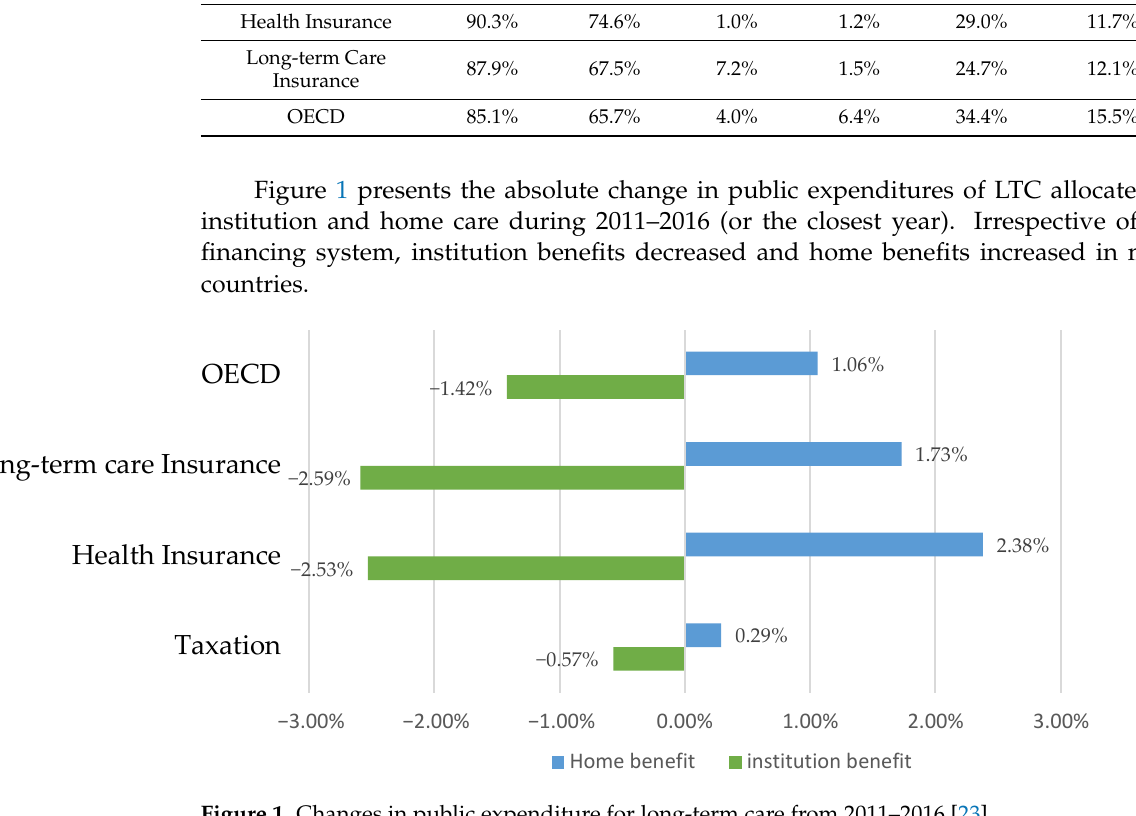
Figure 1. Changes in public expenditure for long-term care from 2011–2016 [23].